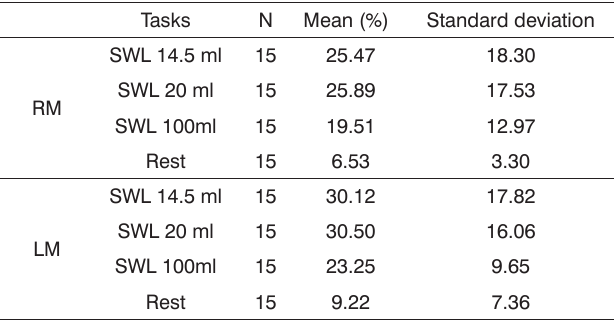
Table 1. Distribution of electric activity of the masseter mus- cle during swallowing of different volumes and a rest in total laryngectomy patients.